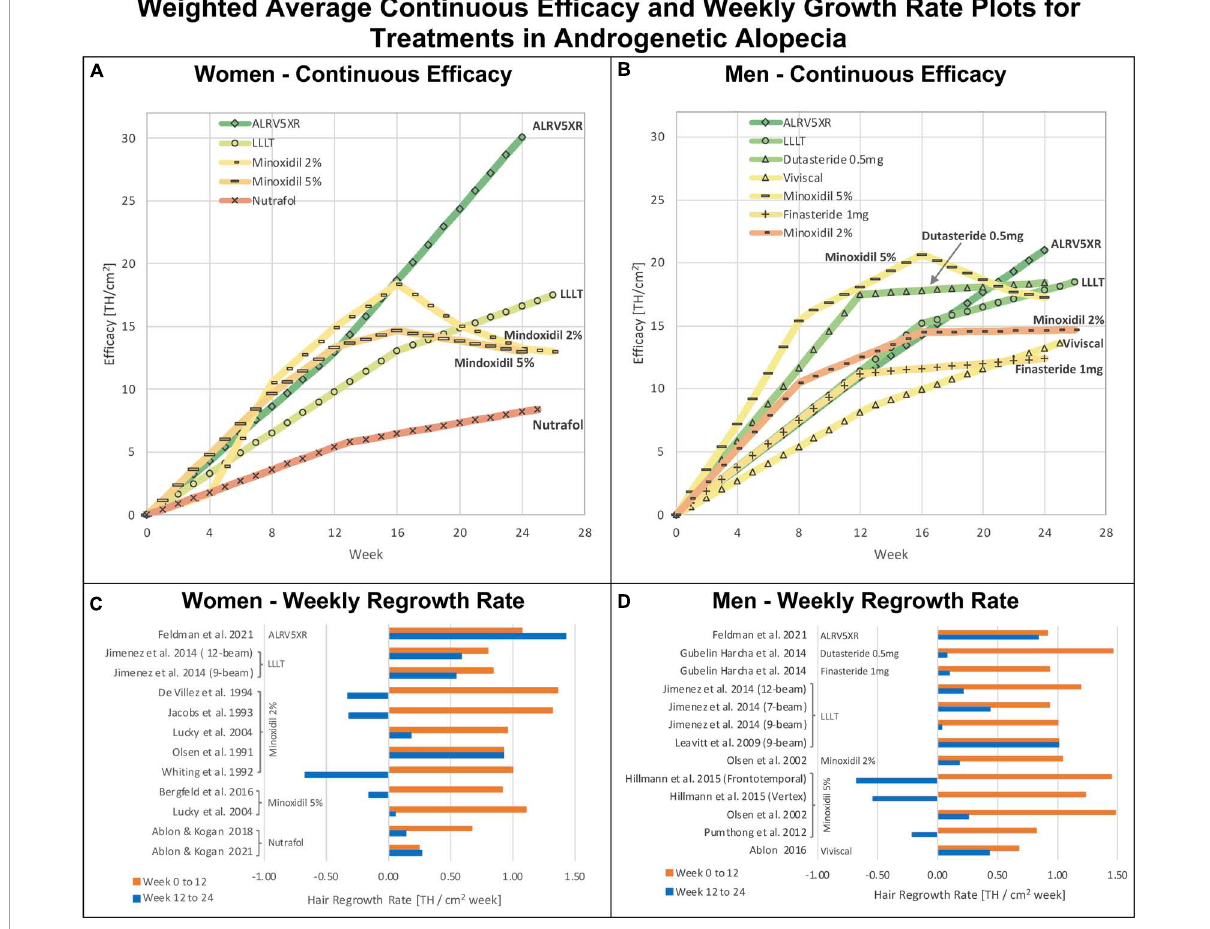
FIGURE8 Weighted average continuous efficacy and weekly regrowth rate plots: Weighted average continuous efficacy plots are in panels (A) for women and (B) for men. Average weekly regrowth rates from 0 to 12 weeks and 12–24 weeks are in panels (C) for women and (D) for men. The continuous efficacy line graphs show the cumulative changes in efficacy for each treatment by sex. They identify two distinct regrowth response profiles common to each treatment in both sexes: Continuous: (ALRV5XR); Resistant: Dutasteride 0.5 mg, Finasteride 1 mg, LLLT, Minoxidil 2% and 5%, Nutrafol, and Viviscal. The colors of treatments in continuous efficacy response lines correspond with the 24 week heat map colors in the Bayesian network meta-analysis in Figure 4